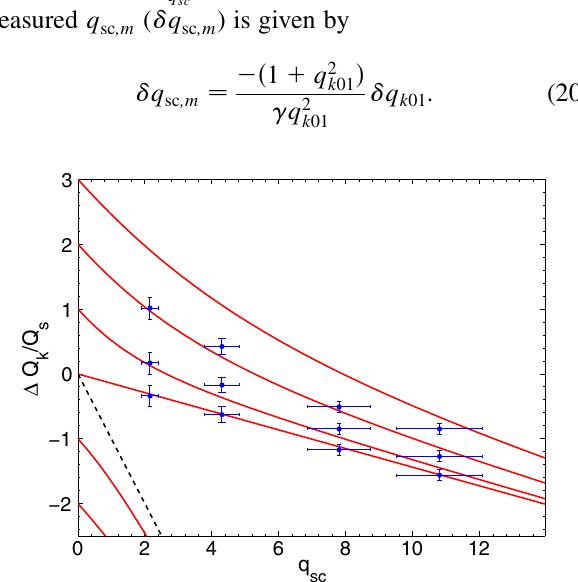
FIG. 15. This plot shows the predicted shifts from analytical Eq. (8) and measured head-tail mode frequencies are overlaid in the vertical plane for N 7 þ ion beam at various current levels (Table